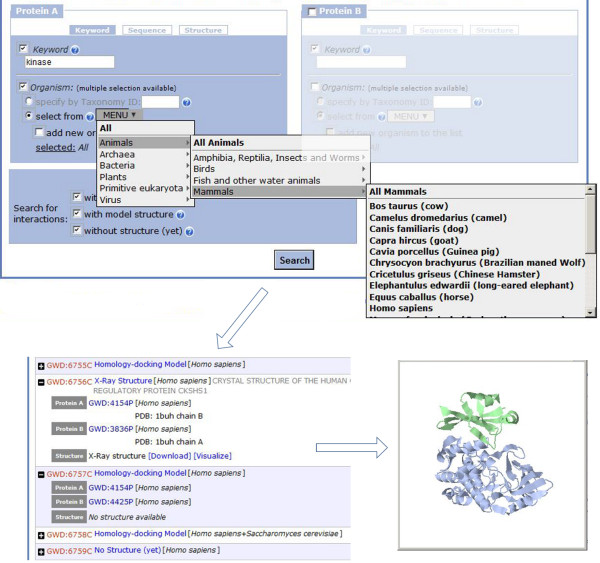
Example of a search.